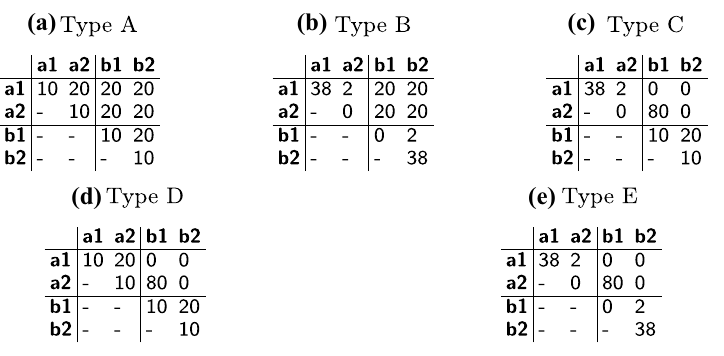
Table 1 Block model for Peel’s